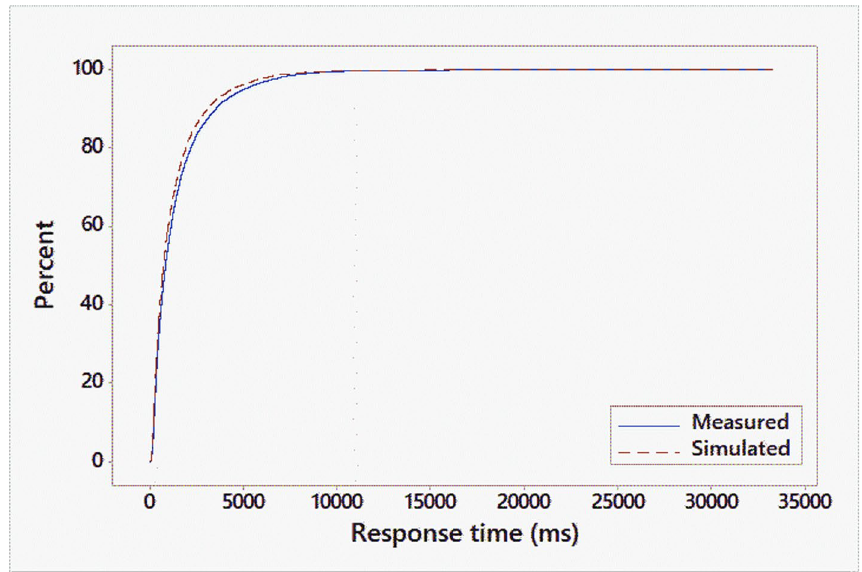
Fig. 11 ECDF plot of measured and simulated values of response time for dynamic load validation scenario, video service, medium